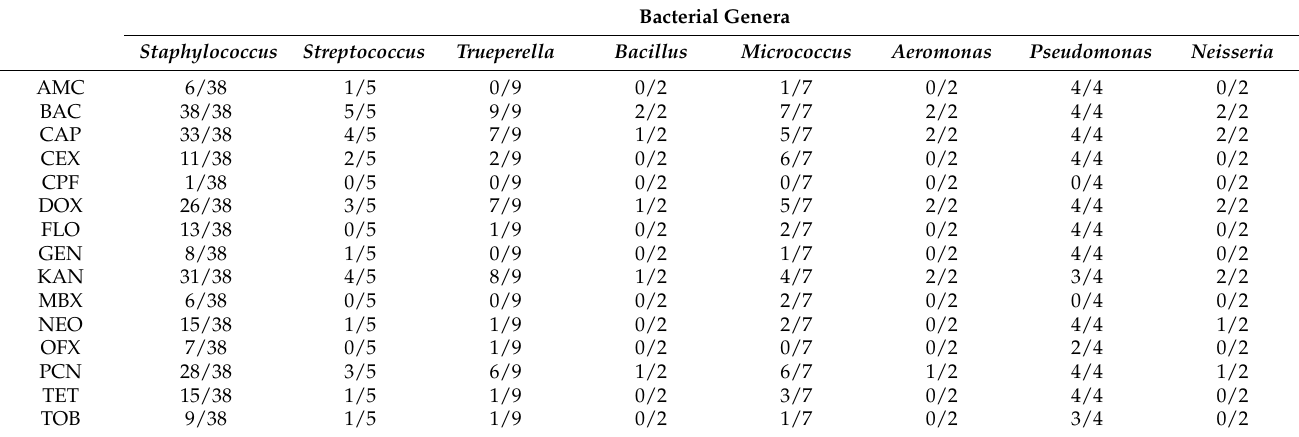
Bacterial Genera